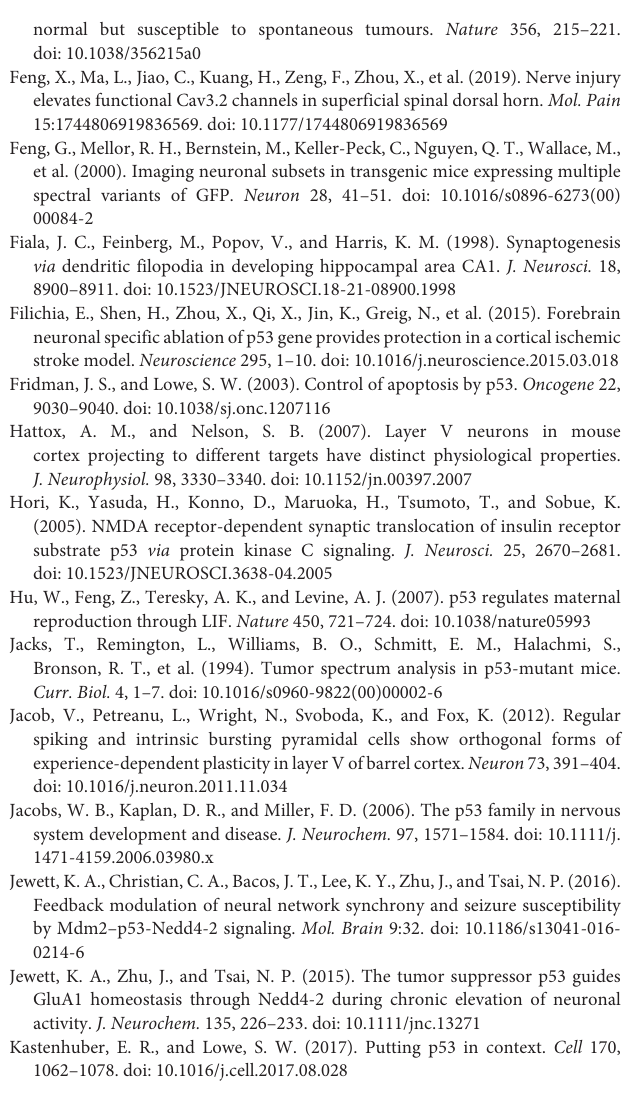
Supplementary Figure 4 | Chronic in vivo quantification of density and dynamics of dendritic spines of L5 pyramidal neurons in S1BF of WT and p53KO mice before and after stimulation. (A,B) Pre-stimulation dendritic spine gained and eliminated ratios. (C–E) Post-stimulation (pre-stim. vs. d12 and d16) fold-change of dendritic spine density (C) , gained spines (D) , and eliminated spines (E) . (F) Survival function of all the spines present at d0. (G) Fraction of persistent spines at d16. * p <